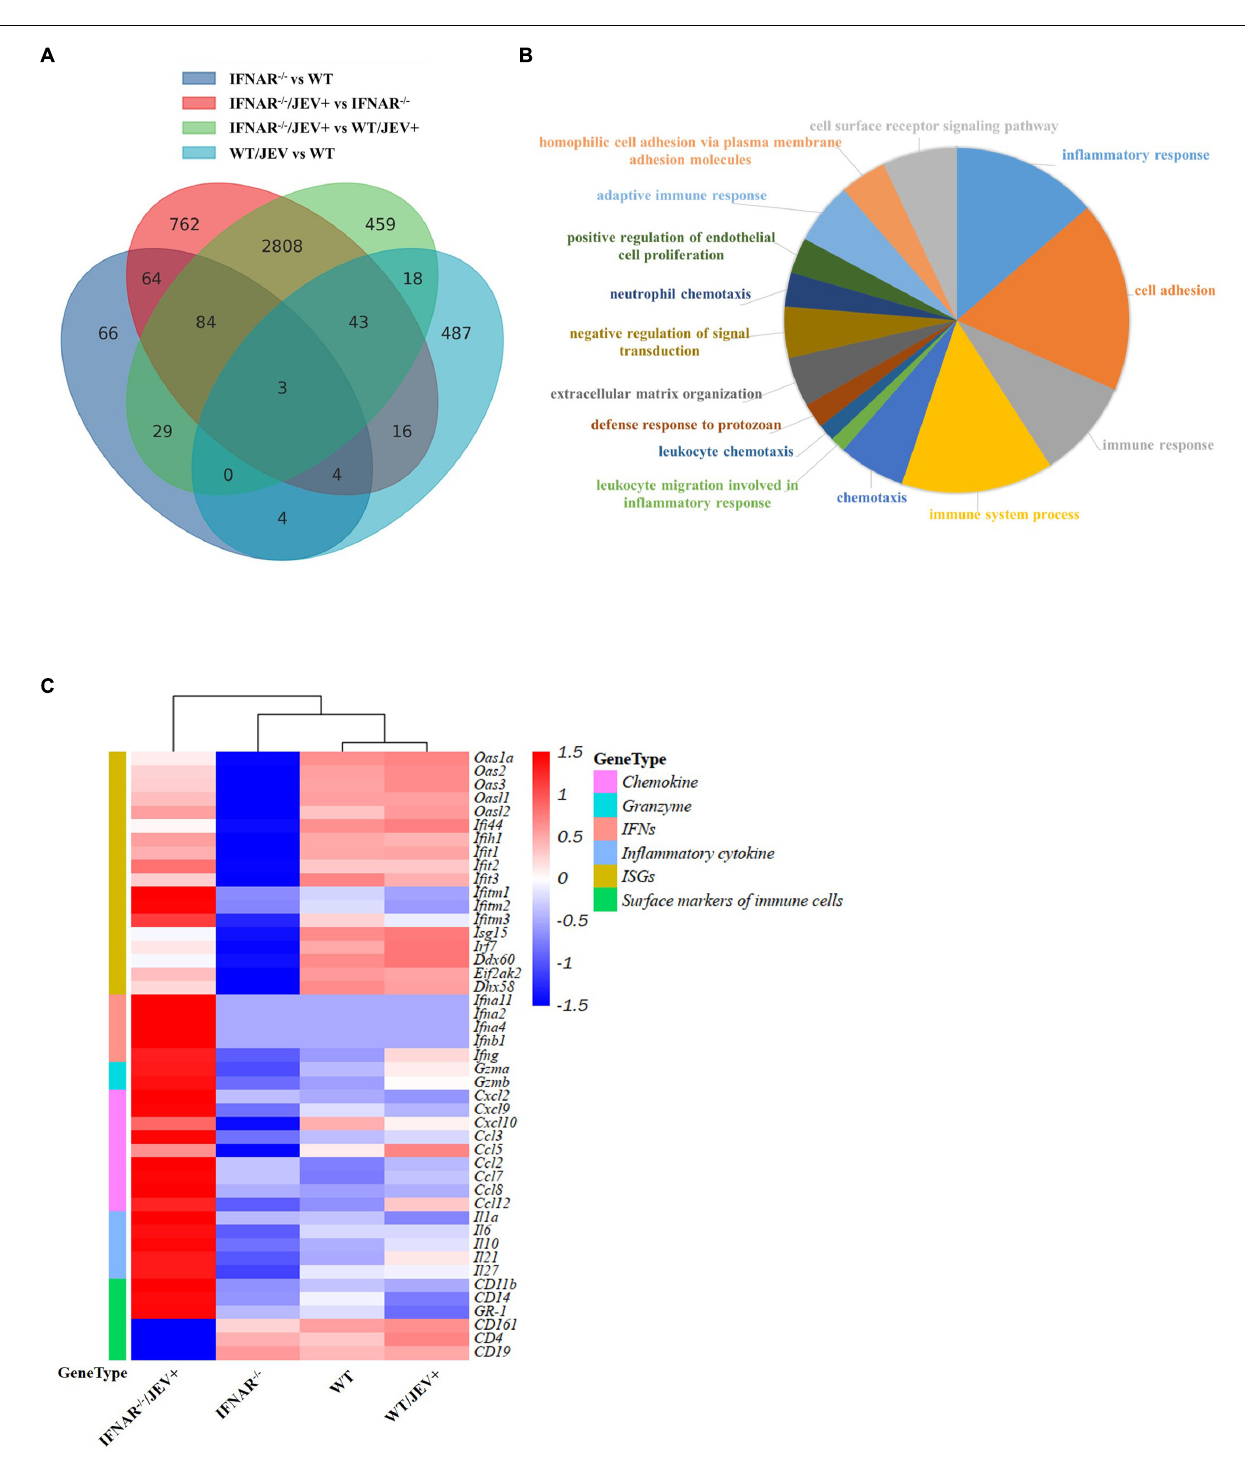
Frontiers in Microbiology |